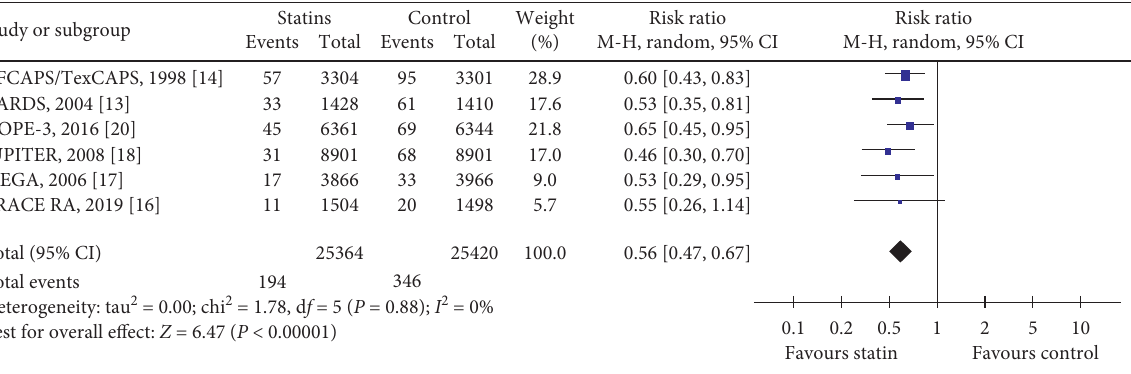
Figure 3: The occurrence of myocardial infarction in included trials.